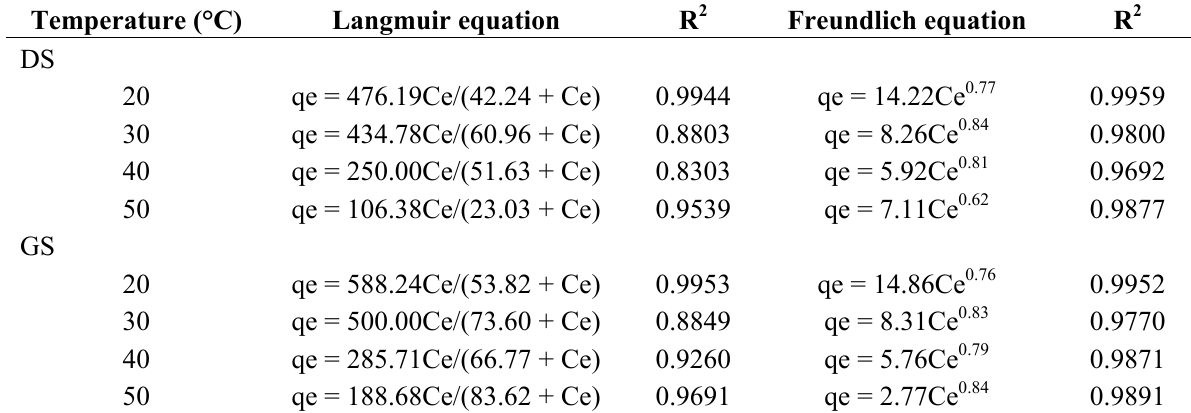
Table 2. Langmuir and Freundlich parameters of DS and GS on HPD5000